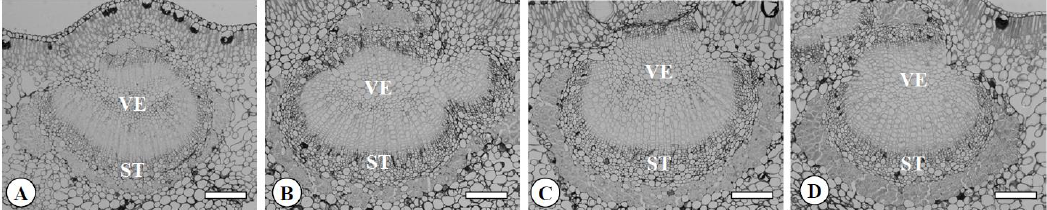
Figure 6. Scanning electron micrographs of pollen grains in the diploid ( A ), the tetraploid ( B ), the Yubeni ( C ), and the chimera ( D ) of the Meiwa kumquat. Bars = 30 μm.